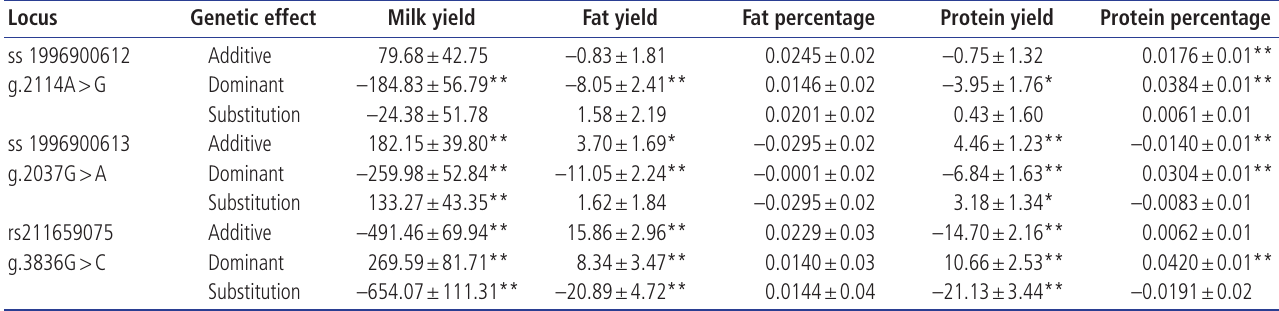
epimerase in Chinese